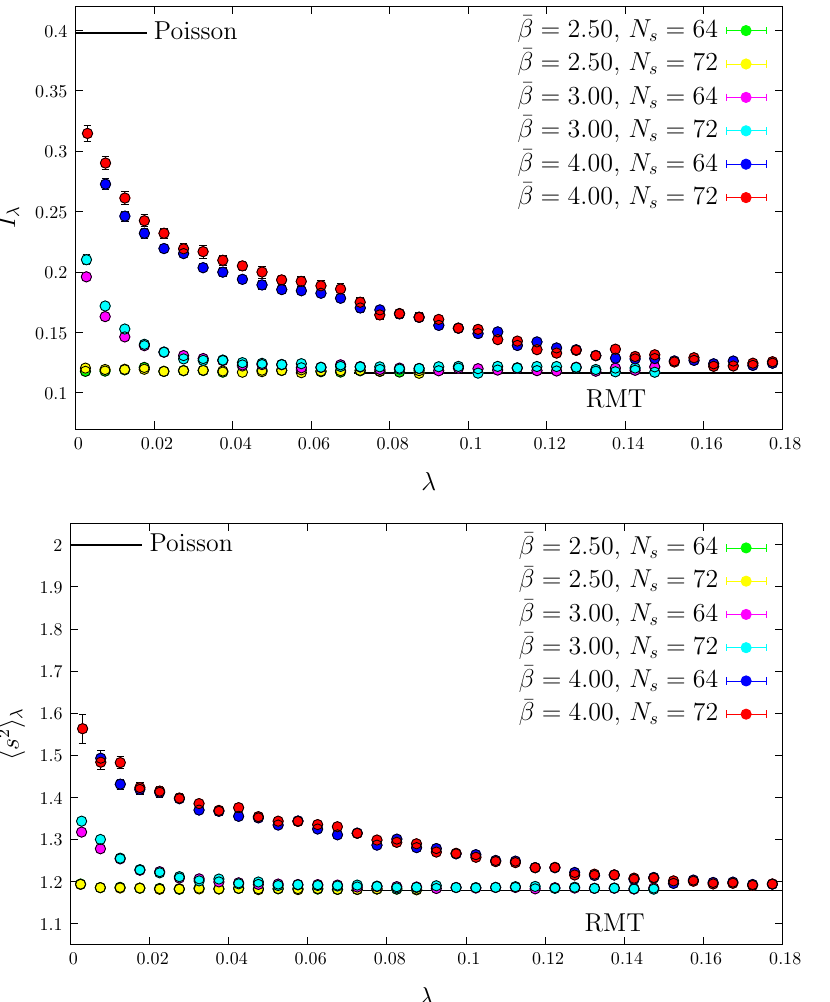
Figure 15 . Spectral statistics I λ (top) and lattice